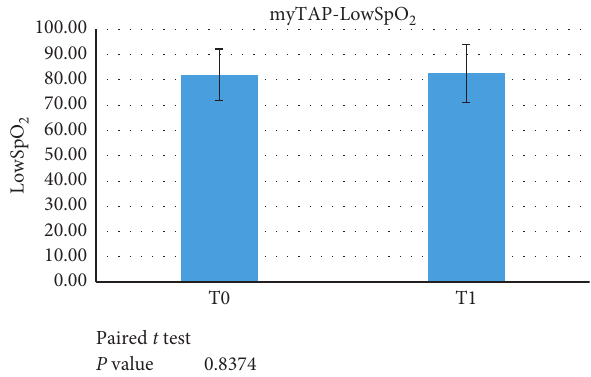
Figure 3: Paired t -test data failed to demonstrate a significant difference between LowSpO 2 at T0 versus T1 ( p < 0 . 05) when evaluating the use of the myTAP ™ device.